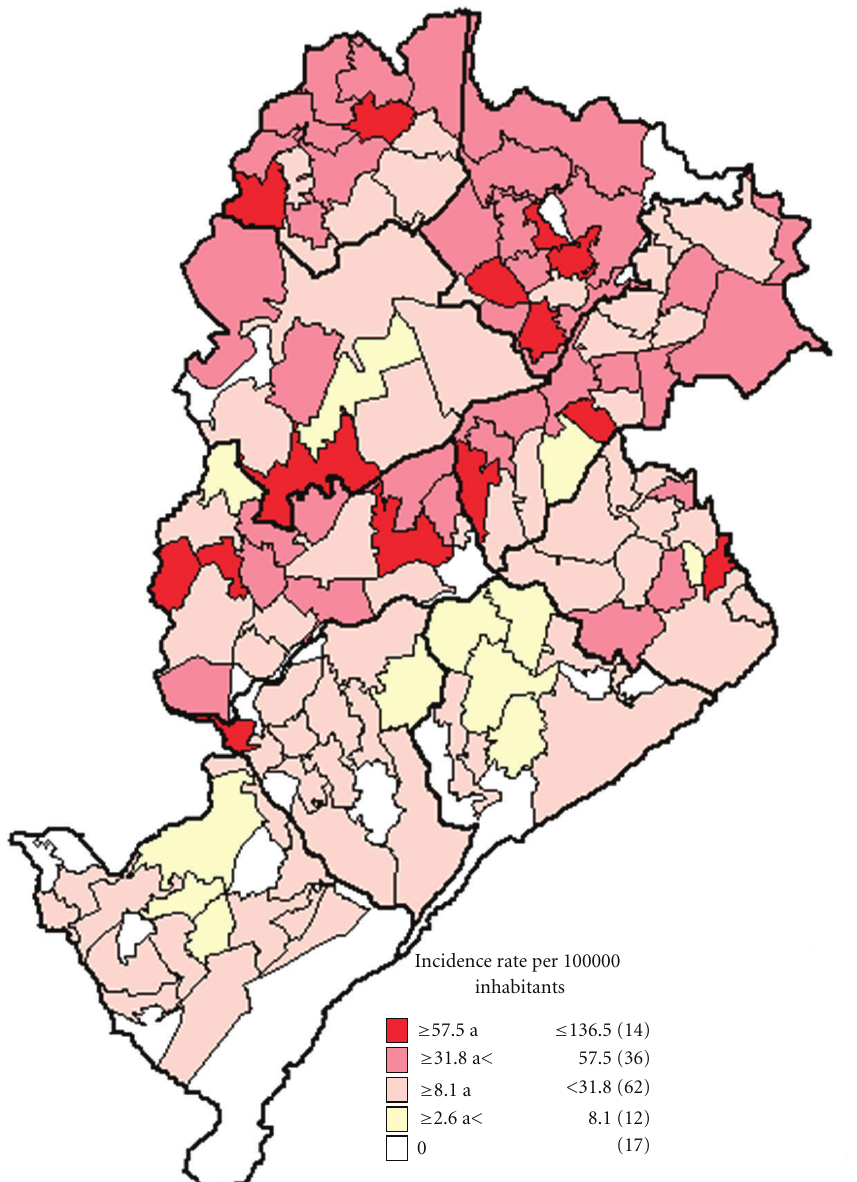
Figure 4: Areas of risk for the transmission of Visceral Leishmaniases in Belo Horizonte City, considering the incidence rates from 2003 to